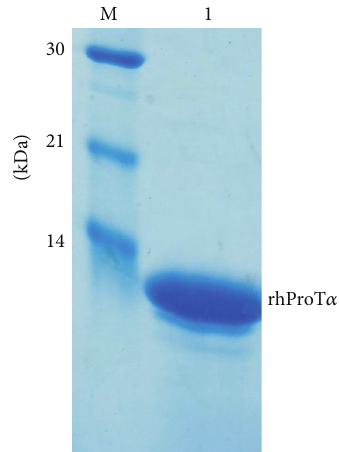
Figure 1: SDS-PAGE of recombinant human prothymosin 𝛼 pro- duced by E. coli . The purified recombinant human prothymosin 𝛼 wasseparatedwith18%SDS-PAGEandstainedwithCoomassieblue G-250. Molecular weight markers were loaded in the same gel (lane